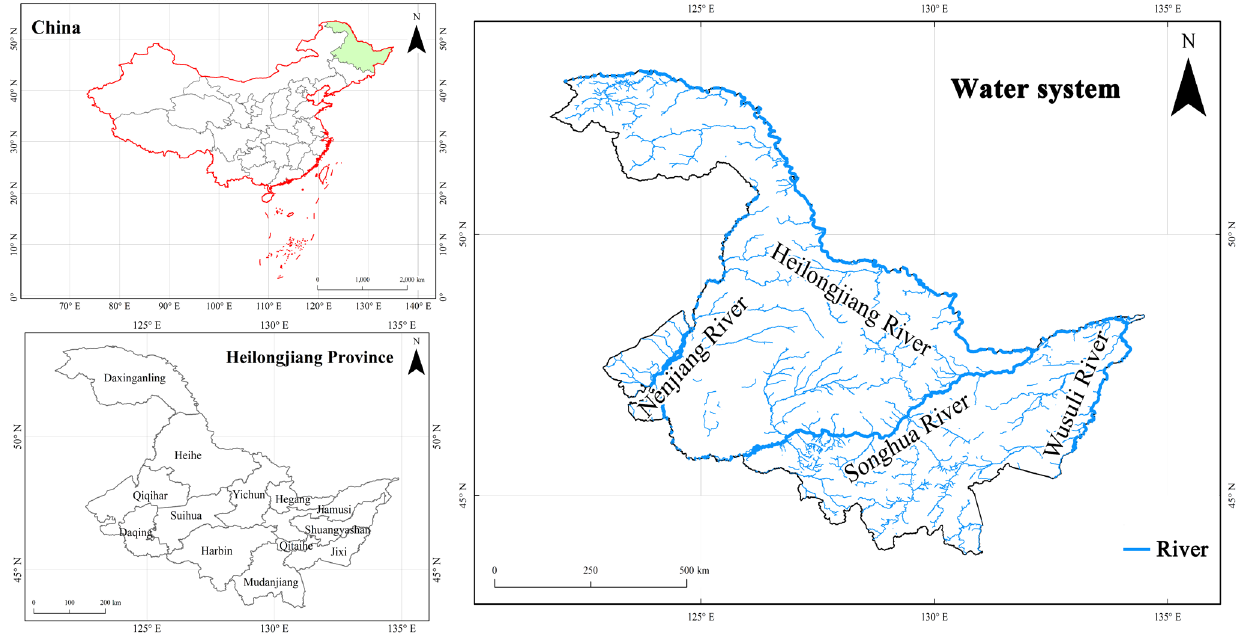
Figure 1. Geographical location and water system of Heilongjiang Province.